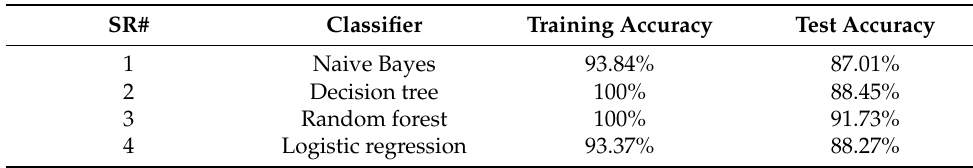
Table 7. The accuracy of various classifiers .